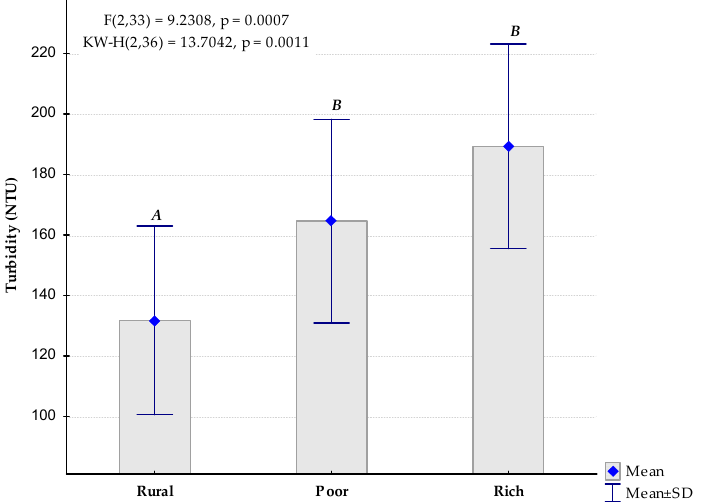
Figure 2. Comparison of mean values of turbidity (all monthly values included per site) between the three study areas. The same letters indicate non-different homogenous groups according to the post-hoc LSD-Fisher test ( p < 0.05).